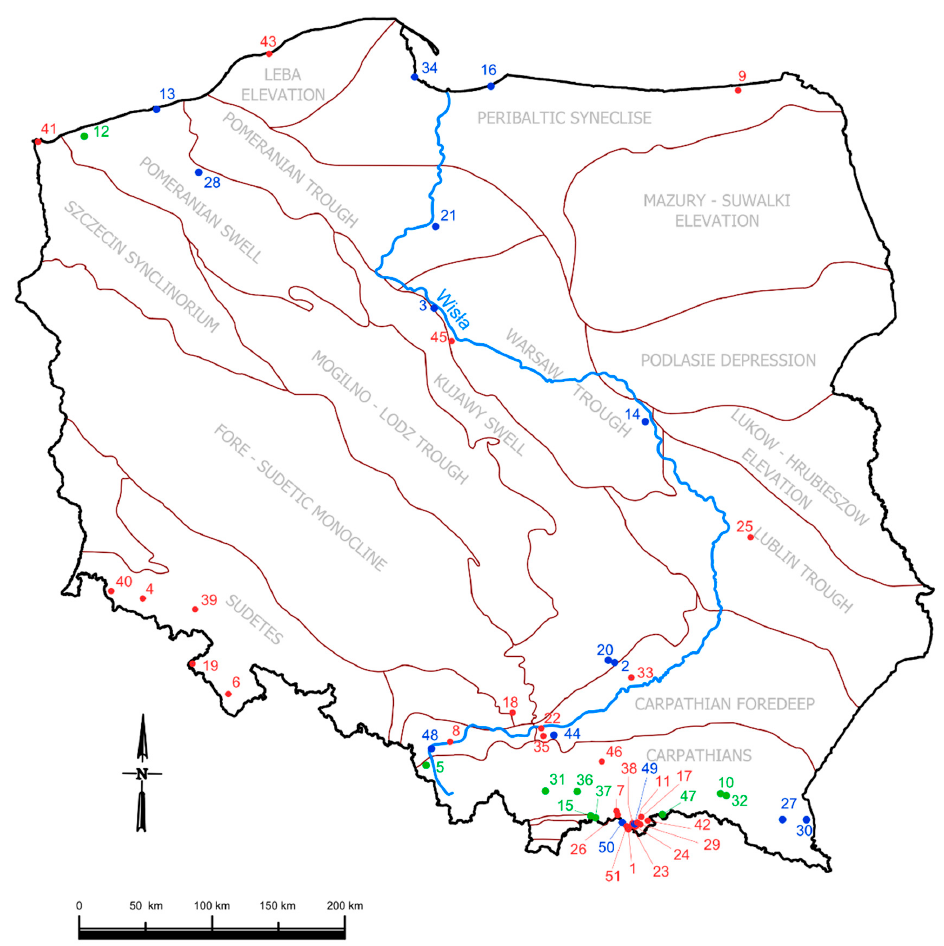
Figure 3. Locations of the investigated curative water on the background of main tectonic structures ( ● red ≤ 5 mg/L; ● blue >5 and ≤ 25 mg/L; ● green color >25 mg/L of boron). 1—Andrzejówka , 2—Busko-Zdrój, 3—Ciechocinek, 4—Jelenia Góra (Cieplice Ś l ą skie-Zdrój), 5—D ę bowiec 6—D ł ugopole-Zdrój, 7—G łę bokie, 8—Gocza ł kowice-Zdrój, 9—Go ł dap, 10—